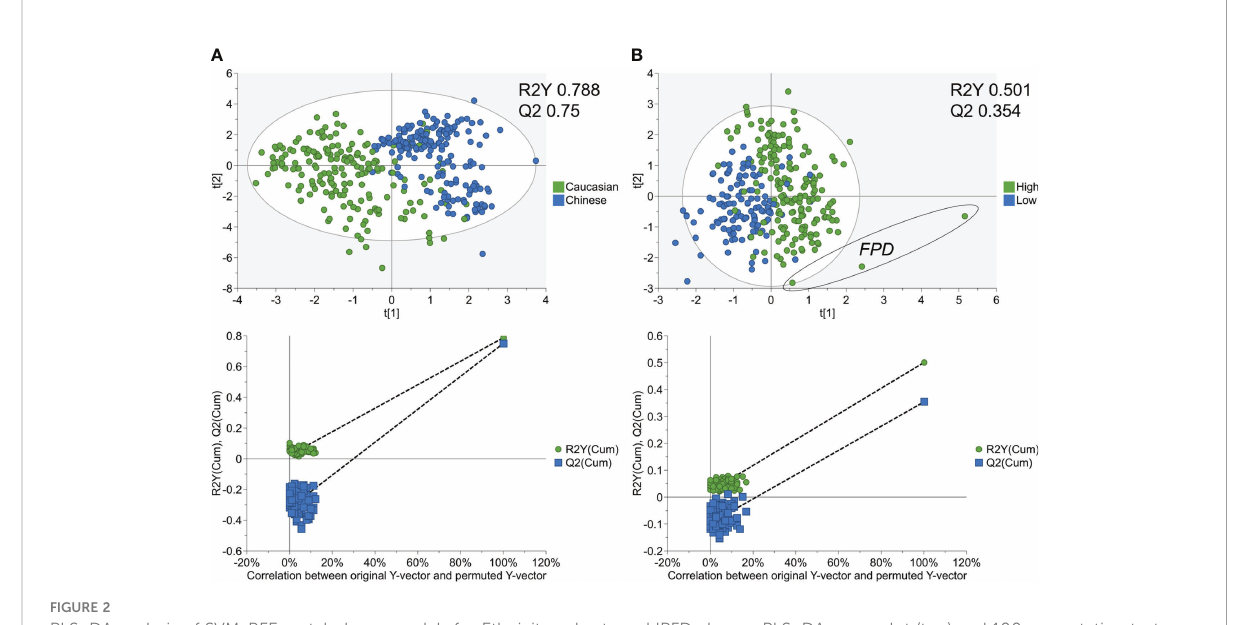
FIGURE 2 PLS − DA analysis of SVM-RFE metabolome models for Ethnicity cohorts and IPFD classes. PLS − DA score plot (top) and 100 permutation tests (bottom) showing A ) good separation and robust model for SVM-RFE ranked metabolites between Caucasian and Asian Chinese, and B ) moderate separation and predictive modelling for SVM-RFE ranked metabolites between Low and High IPFD. FPD, fatty pancreas disease > 10.4%